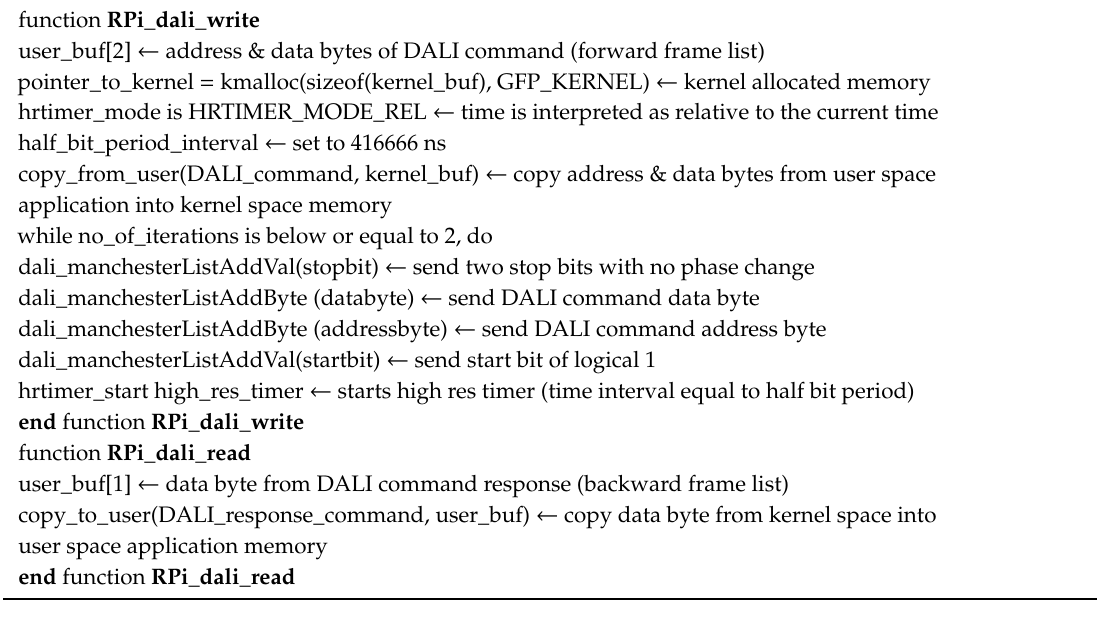
Algorithm 1. DALI read and write kernel module file operations function